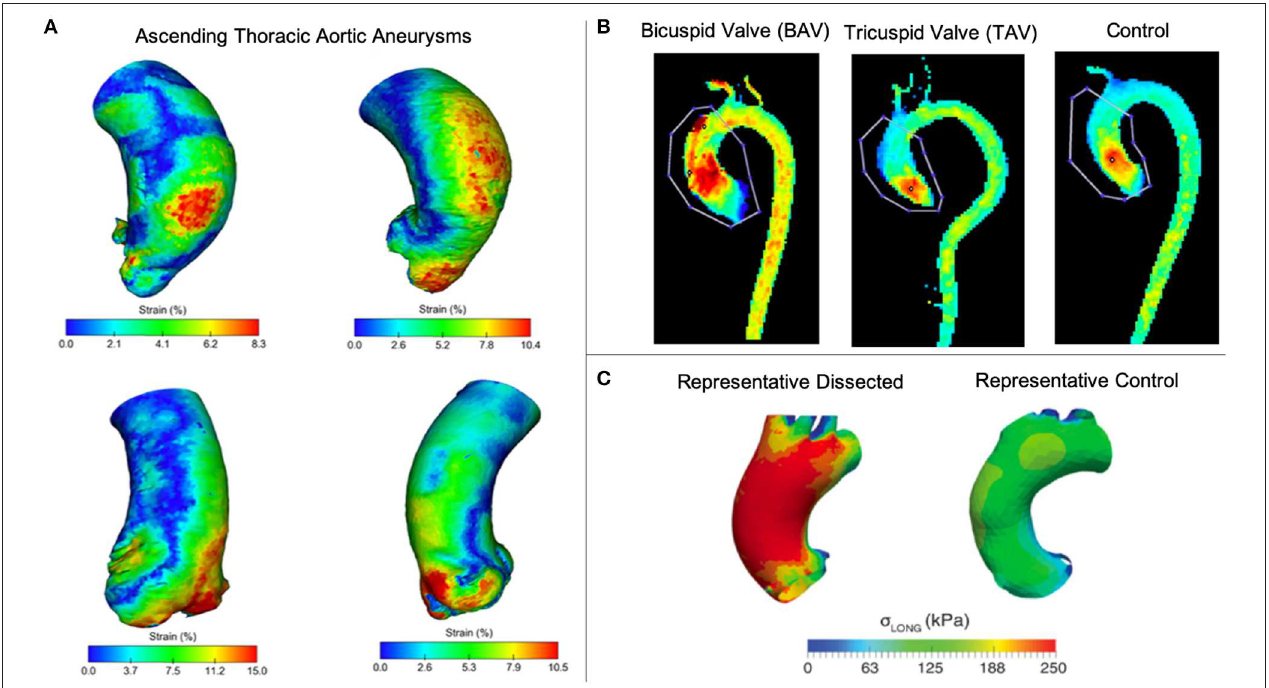
FIGURE 2 | (A) Pasta et al. used gated CT to investigate 3D strain in TAAs (102). (B) Rahman et al. compared peak blood flow velocities between enlarged ascending thoracic aortas (TAV vs BAV) and a control ( 103). (C) Emerel et al. estimated wall stresses in dissected TAAs and compared results normal thoracic aortas (104).